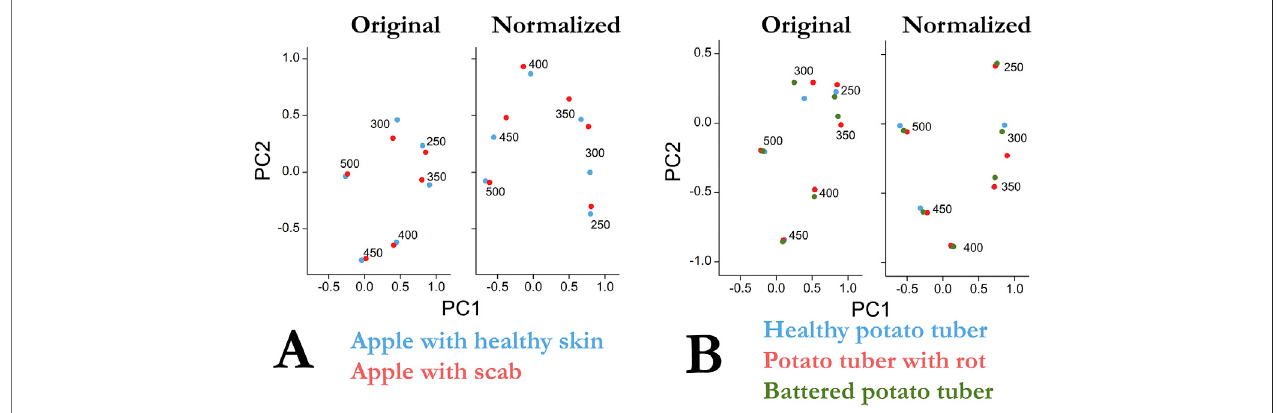
FIGURE3|(A) Resultsofprincipalcomponentanalysisofprimarydataandafternormalizationforuninfected(blue)andinfectedscab(red)Senatorapplesamples. (B) ResultsoftheanalysisofthemaincomponentsoftheprimarydataandafternormalizationforpotatosamplesoftheKumachvariety(blue),withrotting(red),theplace of mechanical damage with a new skin